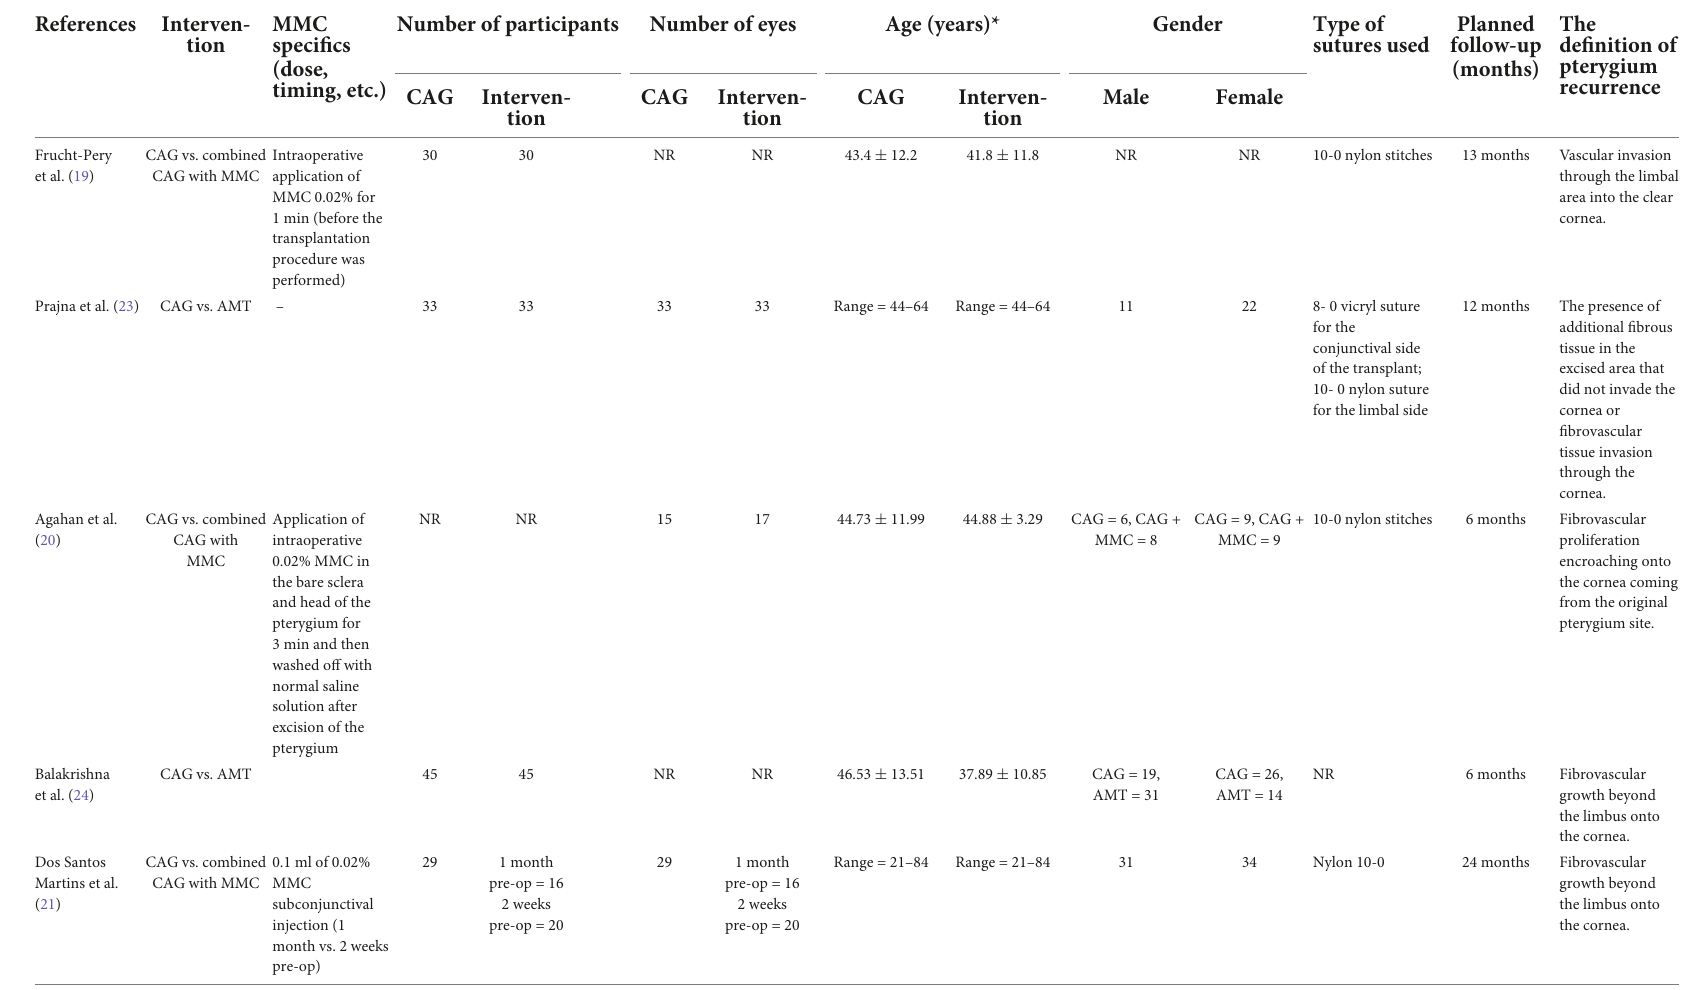
TABLE 1 Characteristics of the included